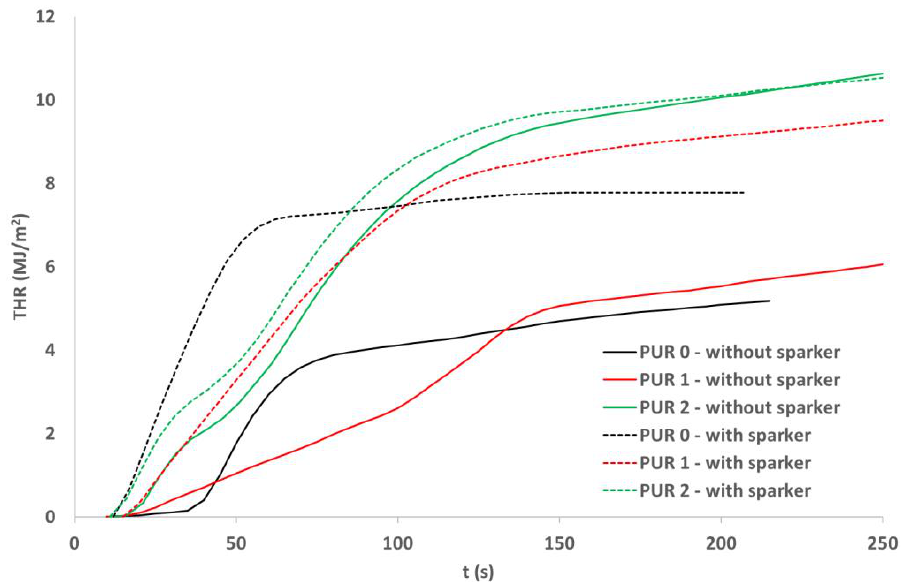
Figure 5. Heat release rate (HRR) of the PURs samples exposed to the 40 kW/m 2 of heat flux; self-ignition and spark ignition.